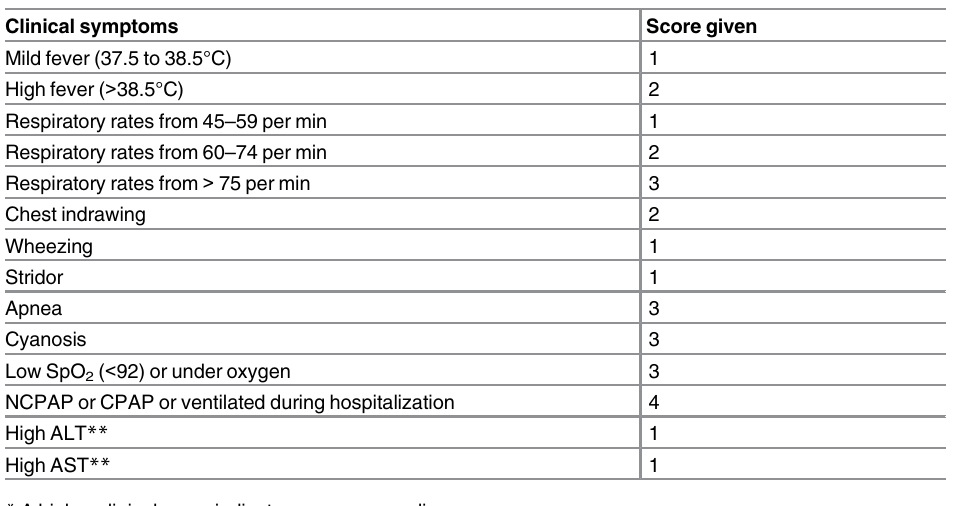
Table 1. Clinical score index * . Clinical